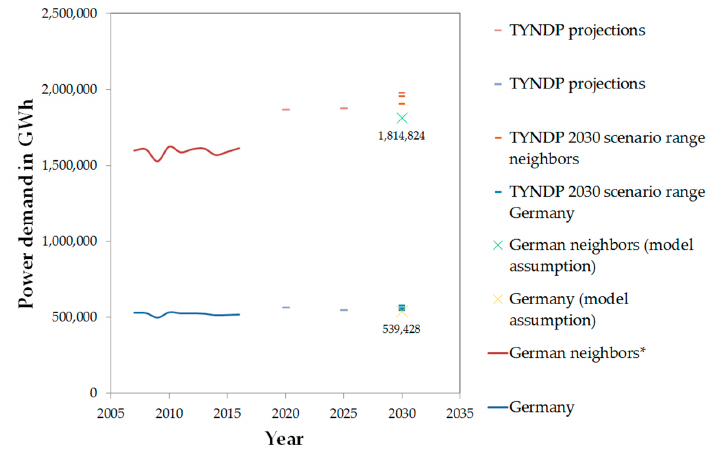
Figure A1. Historic power demand, TYNDP best estimates for 2020 and 2025 as well as scenario values for the scenario "Sustainable Transition" for 2030. The three markers in 2030 present the variety of two TYNDP scenarios, “Sustainable Transition” and “Distributed Generation” as well as an EUCO scenario. Green and orange crosses show the here assumed values from the scenario “Sustainable Transition” corrected by an approximated power demand of the 2030 PEV fleet.